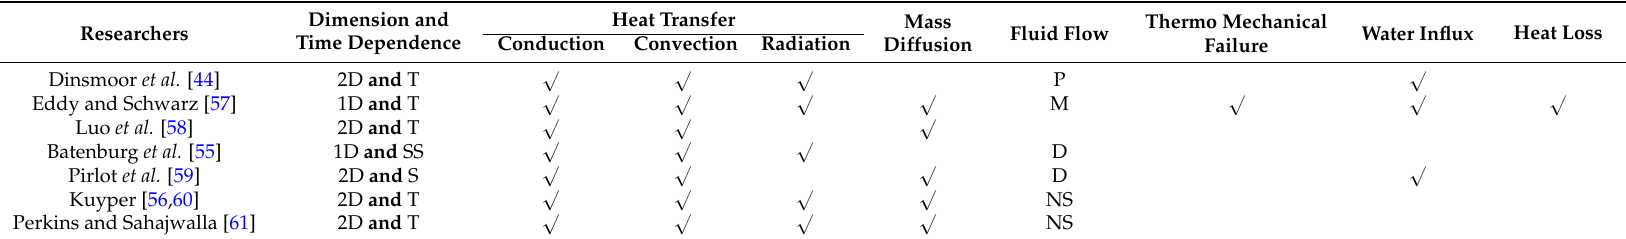
Table 14. Some essential features of reported channel models.